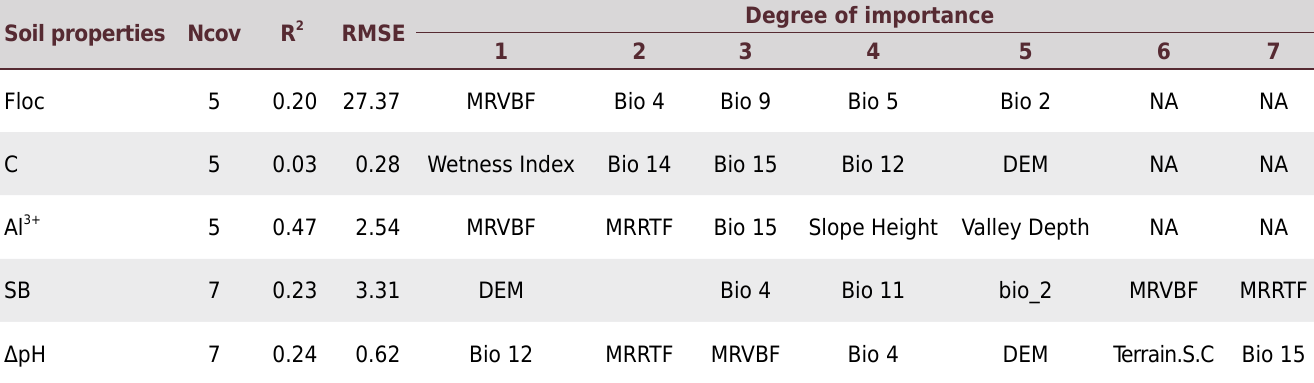
Table 3. Geostatistical results and covariates selection for predicting soil properties Soil properties